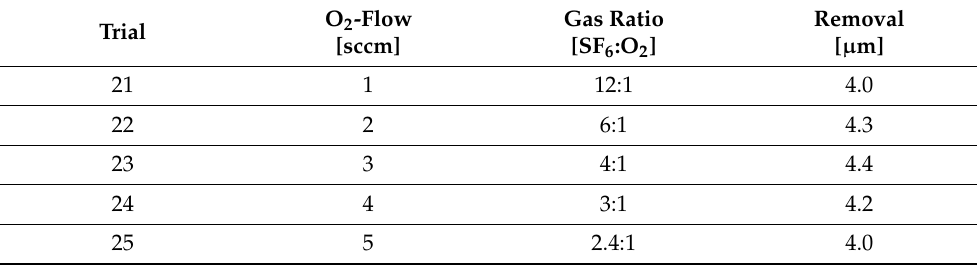
Table 3. Excerpt of the results of the RIE parameter analysis.